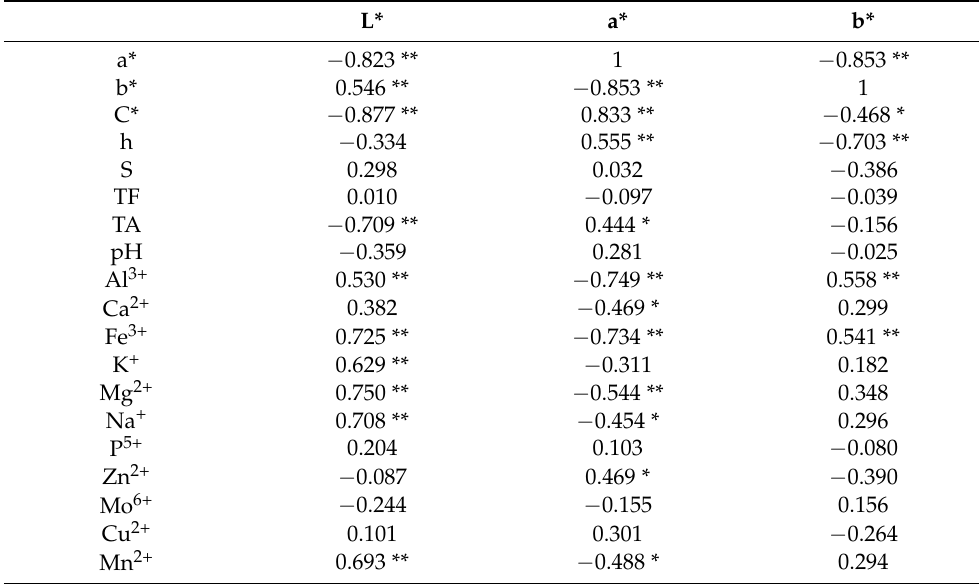
Table 4. Correlation analysis of cellular physicochemical factors with flower color in B. striata